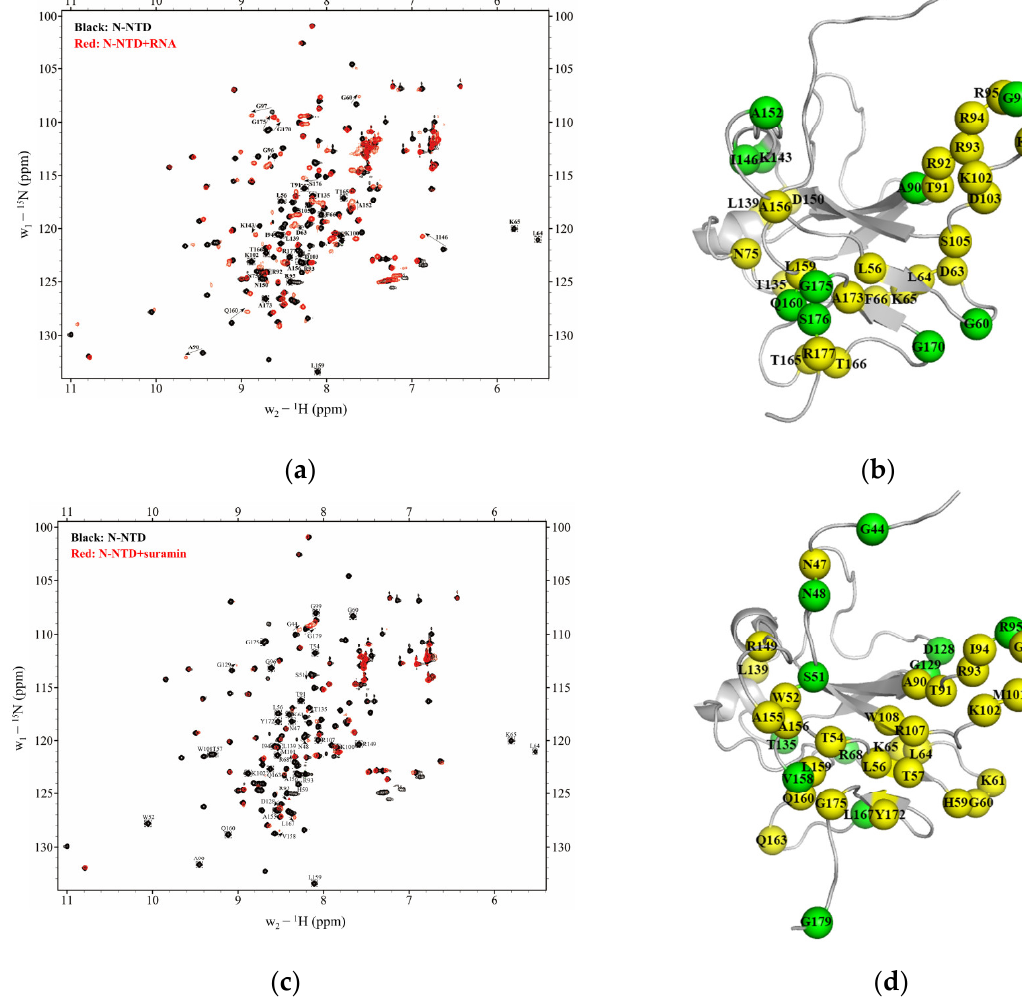
Figure 4. Binding site comparison of ssRNA-16 and suramin on SARS-CoV-2 N-NTD. ( a ) 2D 1 H- 15 N HSQC spectra of N-NTD titrated with ssRNA-16. ( b ) Mapping the residues perturbed during the RNA titration on the 3D structure of N-NTD (PDB ID: 6YI3). ( c ) 2D 1 H- 15 N HSQC spectra of N-NTD titrated with suramin. ( d ) Mapping the residues perturbed during the suramin titration on the 3D structure of N-NTD (PDB ID: 6YI3). The broad peaks are indicated in the dashed rectangles in the spectra and the corresponding residues are shown in yellow in the structure, while the shifted peaks are indicated as arrows and the corresponding residues are shown in